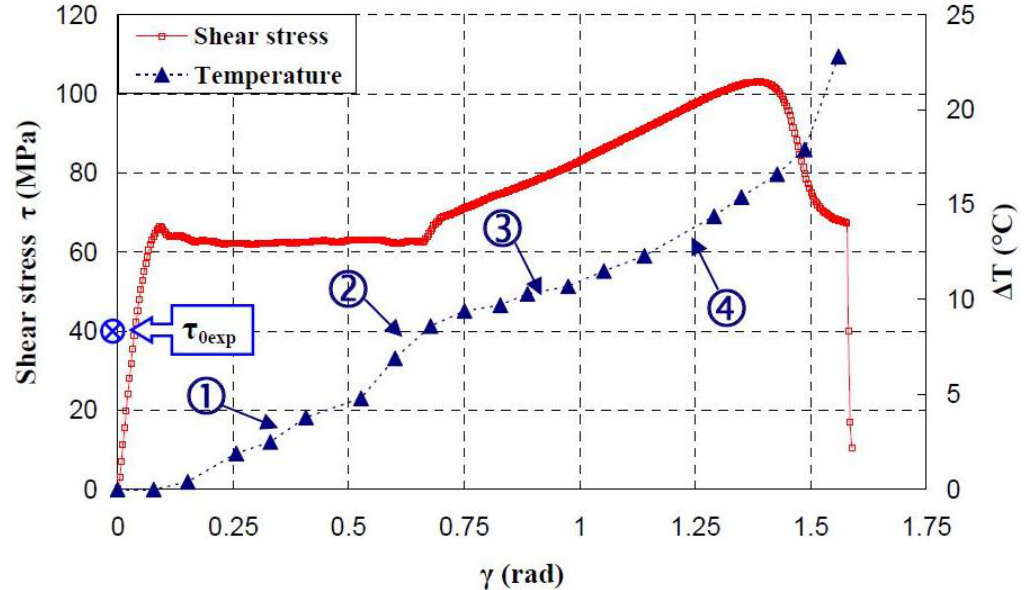
Figure 25. Thermal dissipation and shear stress of PC polymers during the torsion